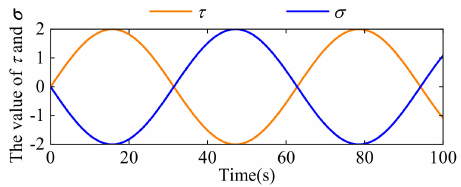
Figure 21. Sine σ and τ